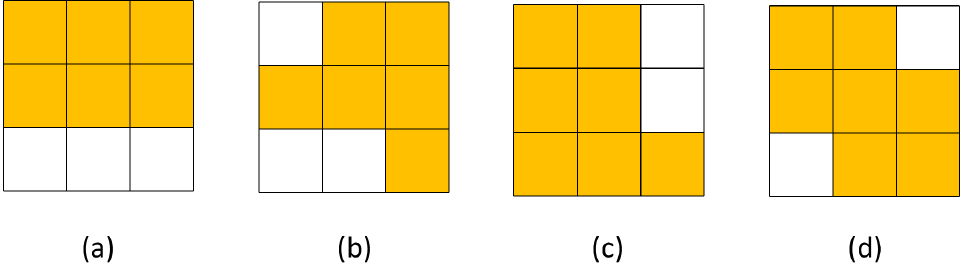
Figure 5. Some special situation of a single receptive field. ( a , b ) 6 pixels detected image; ( c , d ) 7 pixels detected